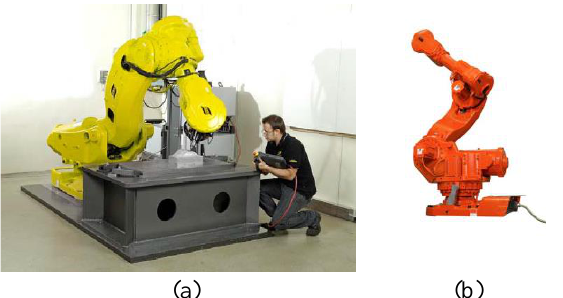
Fig. 5. Industrial robots equipped with friction stir welding head ESAB Rosio (Sweden) (a) and ABB IRB 7600 (Switzerland) (b).